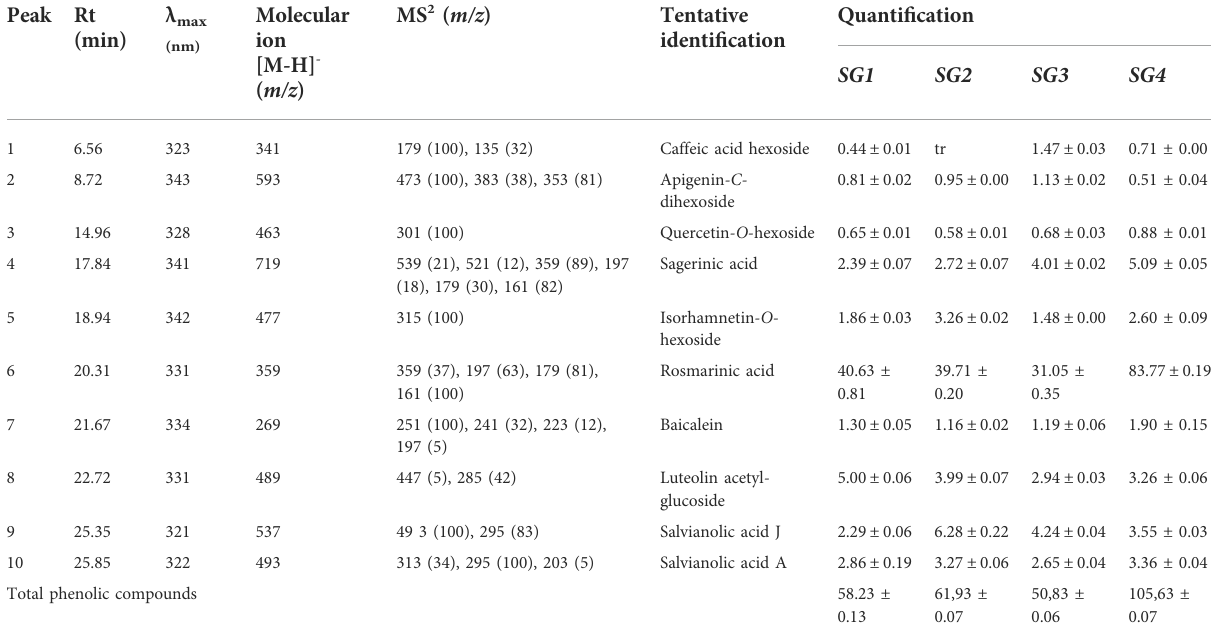
TABLE 1 Chromatographic features, qualitative and quantitative distribution (mg/g of extract) of the phenolic compounds present in extracts from Salvia glutinosa L. Peak Rt (min)